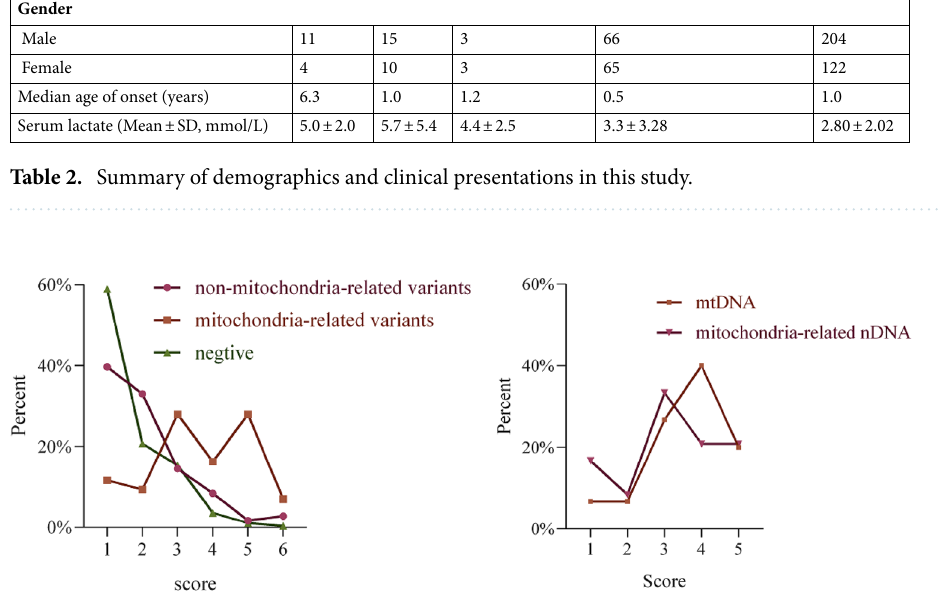
Figure 2. Percentages distribution of different groups referring to MDC scores. Left, comparison of three groups including negative, mitochondria-related and non-mitochondria-related nDNA variants. Right, comparison between mtDNA and mitochondria-related nDNA